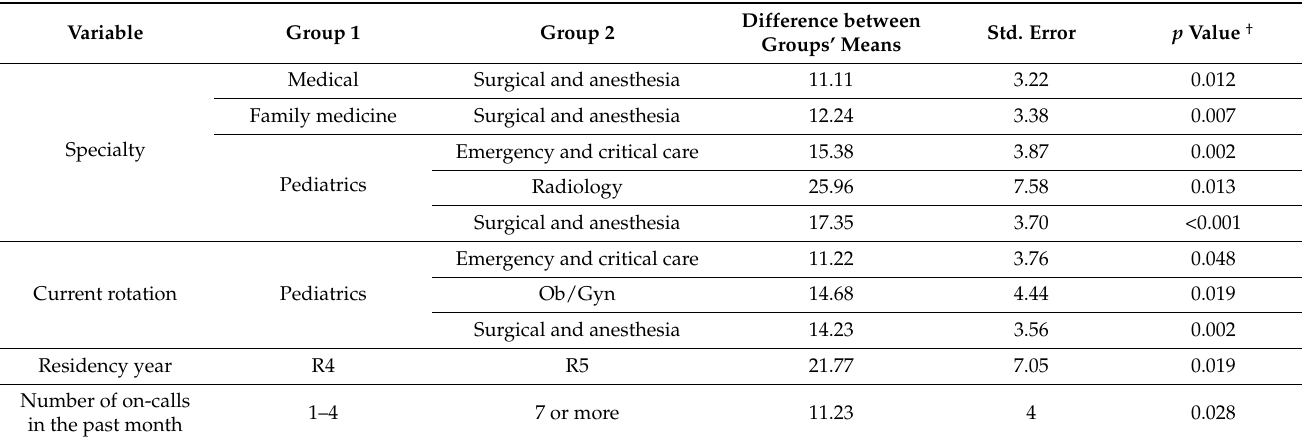
Figure 3. Stacked bar chart of residents’ responses to items 6, 17, and 18 of the JSE ( n = 229). Table 3. Pairwise comparisons with significant differences in means between categories based on post hoc analysis.*